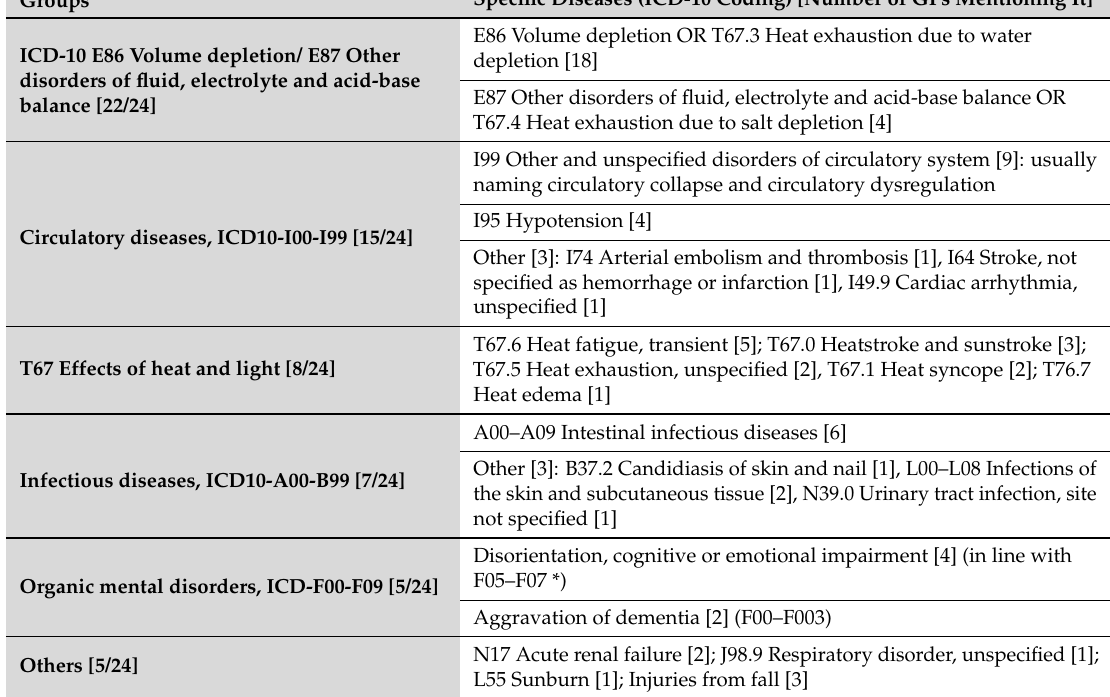
Table A3. GPs’ perceptions of heat related morbidity (Heat-related diseases mentioned by GPs, coded according to